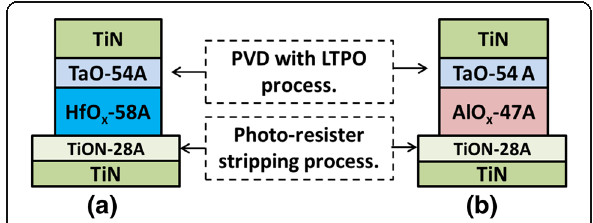
Fig. 1 Cell schematic plots with thickness information for a TaO/ HfO x devices and b TaO/AlO x devices. Both plots describe devices for which PVD deposited the TaO layers with LTPO processes, and the bottom TiON interfacial layers were formed by plasma oxidation during photoresist